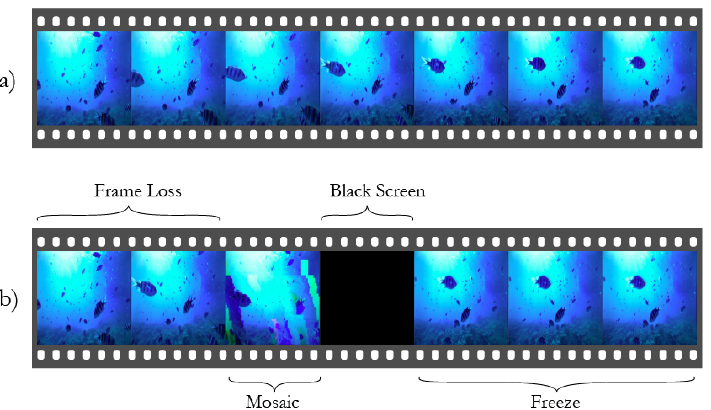
Figure 1. Example of a regular sequence of frames ( a ) and an anomalous sequence with simulations of four types of defects ( b